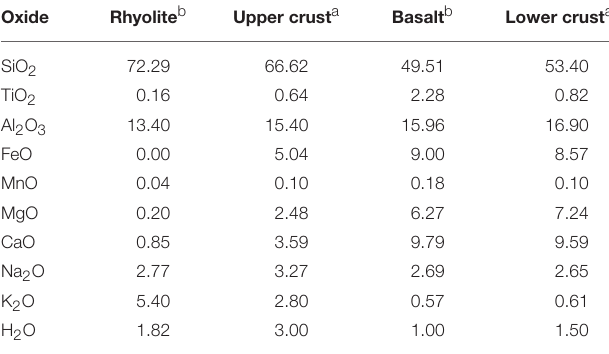
TABLE 1 | Major element composition (in weight percent oxide) for all rock types used in this work. Oxide Rhyolite b Upper crust a Basalt b Lower crust